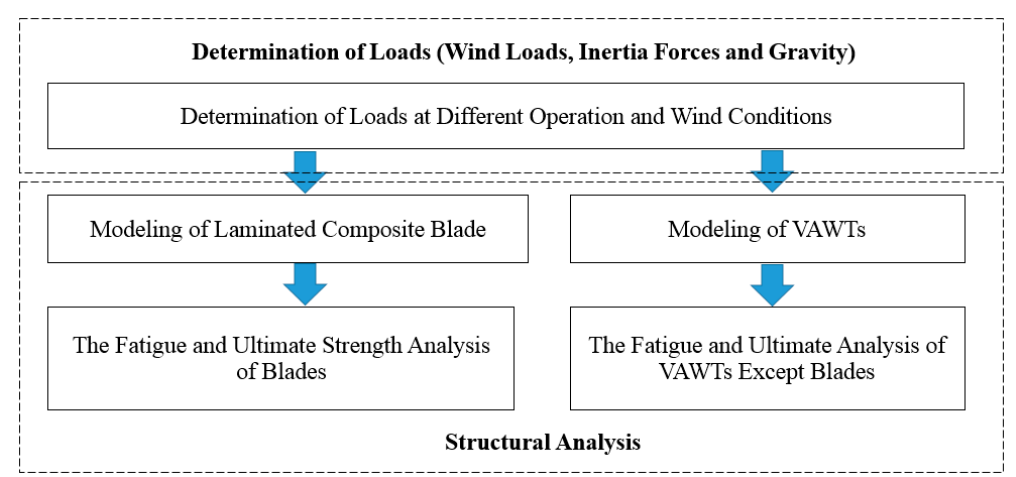
Figure 1. Structural analysis framework of vertical axis wind turbines (VAWTs).